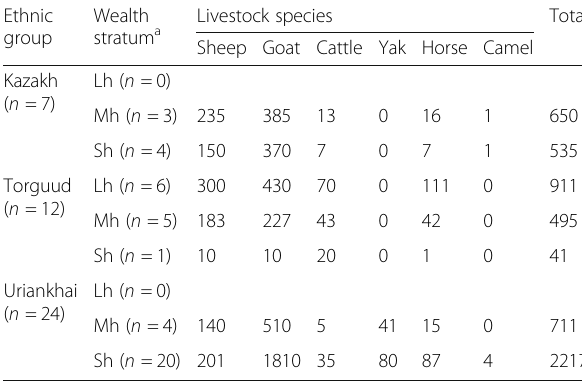
Table 4 Cumulated livestock losses in the Mongolian Altai across ethnic groups and wealth strata during the 2009/10 dzud Ethnic Wealth group stratum a